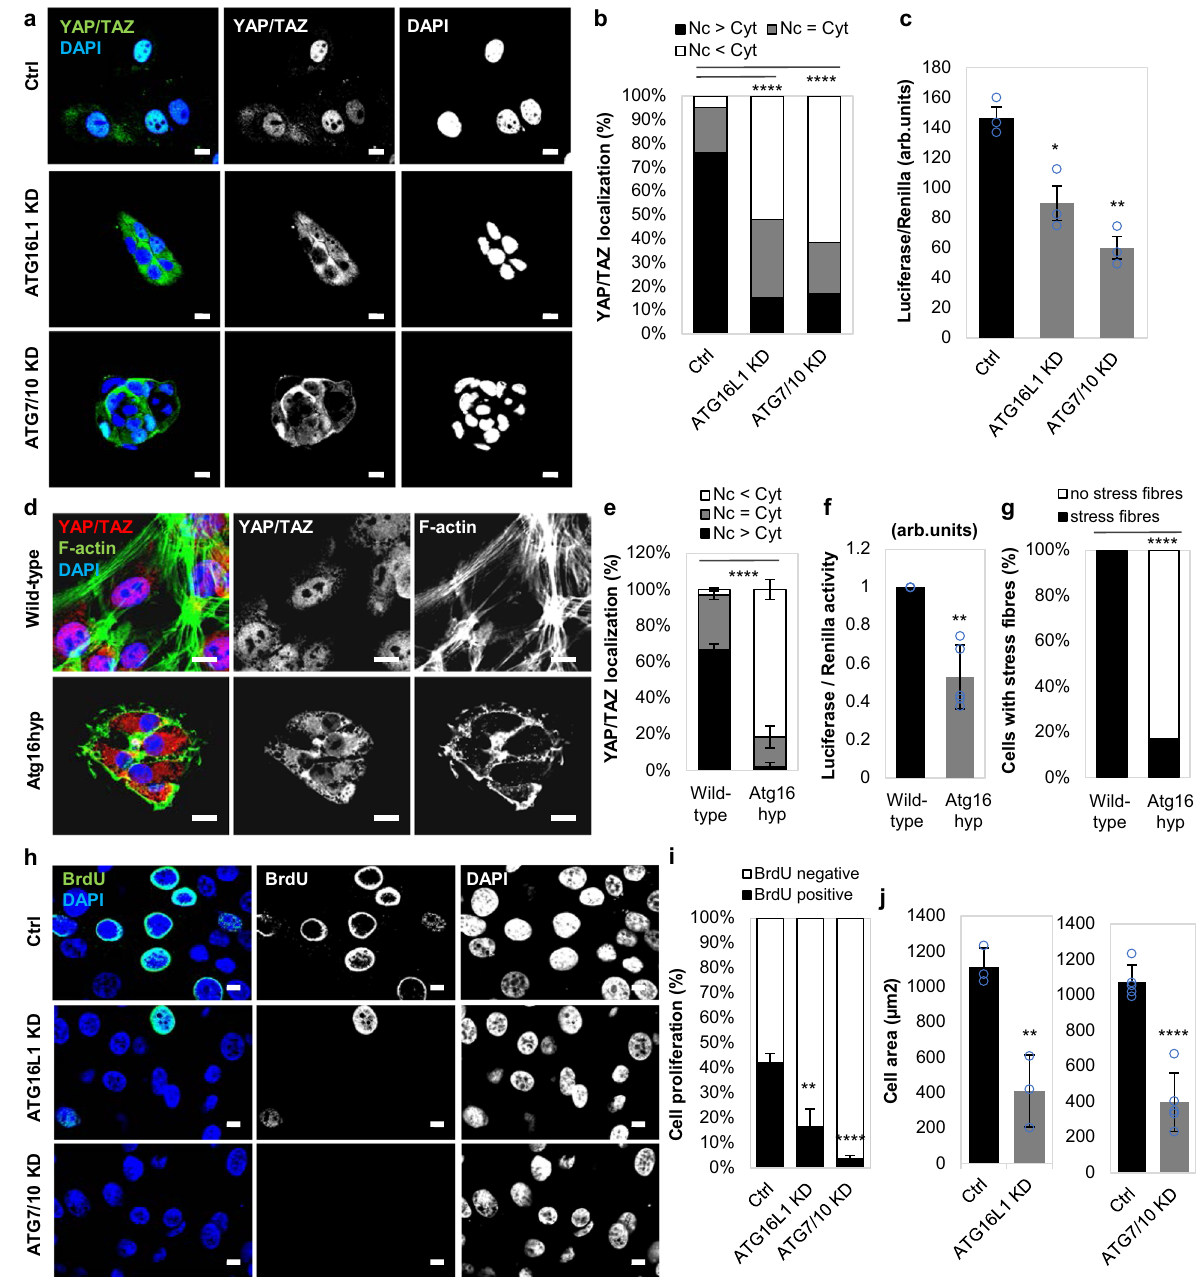
Fig. 1 YAP/TAZ activity is inhibited in autophagy-de fi cient mammary epithelial cells. a Representative confocal images of YAP/TAZ endogenous immunostaining in MCF10A cells exposed to control, ATG16L1 or ATG7/10 siRNAs. DAPI = nucleus. Scale bars are 10 µ m. The experiment was repeated twice with similar results. b YAP/TAZ localisation (nuclear — Nc or cytoplasmic — Cyt) in MCF10A cells exposed to control, ATG16L1 or ATG7/10 siRNAs ( n = 126 (Ctrl), 170 (ATG16L1 KD), 166(ATG7/10 KD) cells; **** P <0.0001; chi-squared test). The experiment was repeated twice with similar results. c Luciferase assay for YAP/ TAZ activity in MCF10A cells exposed to control, ATG16L1 or ATG7/10 siRNAs. Bars represent the mean±s.d. ( n = 3 independent experiments; ** P <0.01, * P < 0.05; two-tailed one sample t -test). d Representative confocal images of endogenous YAP/TAZ and F-actin (Phalloidin) in primary mammary epithelial cells (pMECs) isolated from wild-type and Atg16L1 hypomorph (Atg16hyp) mice. Scale bars are 10 µ m. The experiment was repeated twice with similar results. e YAP/ TAZ localisation in wild-type ( n = 3 mice) and Atg16hyp ( n = 4 mice) pMECs. Bars represent the mean±s.d. (**** P <0.0001; two-way ANOVA). f Luciferase assay for YAP/TAZ activity in wild-type and Atg16hyp pMECs. Bars represent the mean±s.d. ( n = 3 mice; ** P <0.01; two-tailed one sample t -test). g Percentage of cells with F-actin stress fi bres in wild-type and Atg16hyp pMECs ( n = 98 (wild-type) and 292 (Atg16hyp) cells; **** P <0.0001; chi-squared test). The experiment was repeated twice with similar results. h Representative images of BrdU immunostaining in MCF10A cells exposed to control, ATG16L1 or ATG7/ 10 siRNAs. Scale bars are 10 µ m. The experiment was repeated twice with similar results. i The graphs show the percentages of BrdU-positive MCF10A cells, after exposure to control, ATG16L1 or ATG7/10 siRNAs: mean±s.d. ( n = 3 independent experiments; **** P <0.0001, ** P <0.01; two-tailed t -test). j Size of autophagy inhibited cells: MCF10A cells exposed to control, ATG16L1 ( n = 3 independent experiments) or ATG7/10 ( n = 5 independent experiments) siRNAs. Confocal images of each cell type were analysed to measure cell area using ZEN software. Bars represent the mean±s.d. (**** P <0.0001, ** P <0.01; two-tailed t -test). Exact P values for asterisks: c (from left to right) 0.0132, 0.0010; f 0.0033; i 0.0058; and j